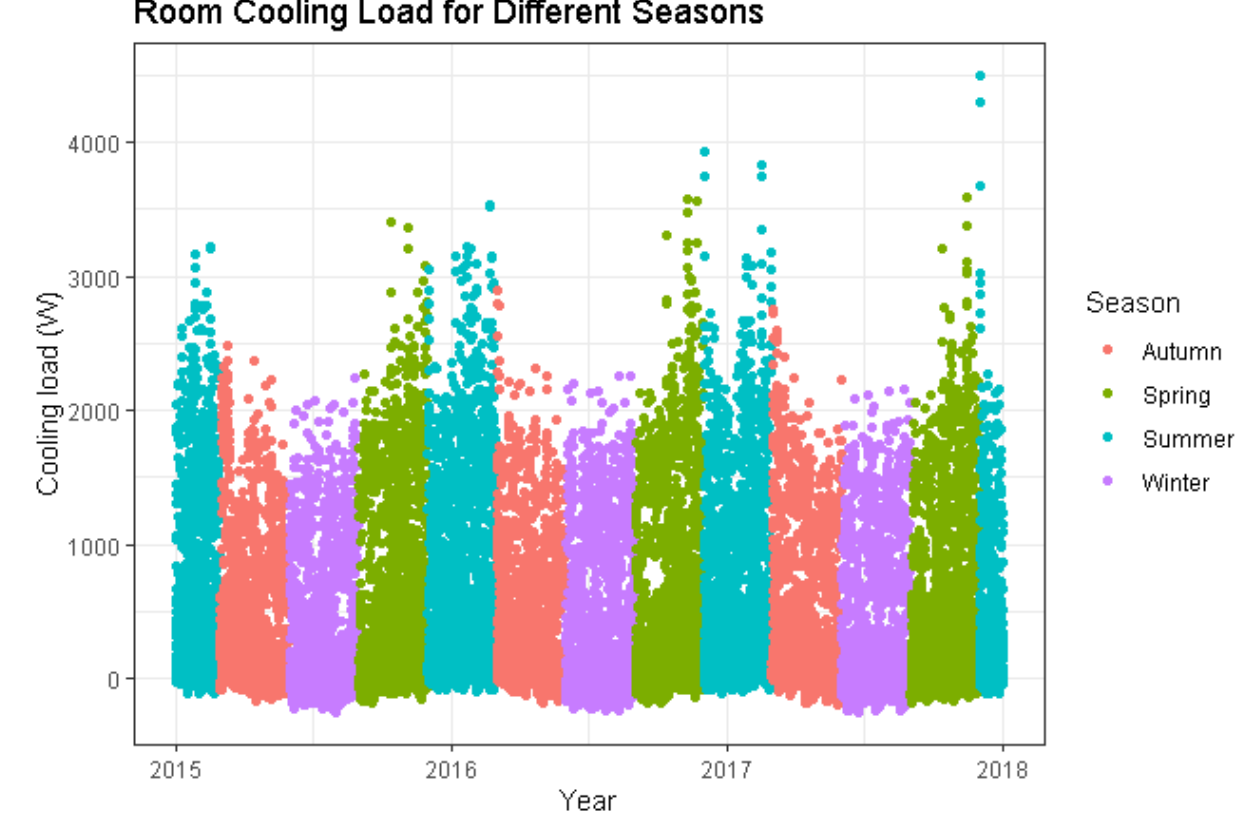
Figure 2. Room cooling load related to different hours from 1 January 2015 to 31 December 2017.